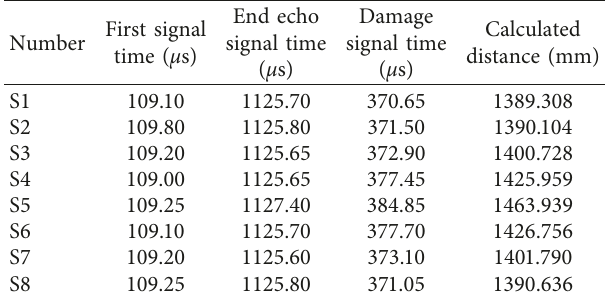
Table 6: Experimental data of the guided wave signals in single damage section.